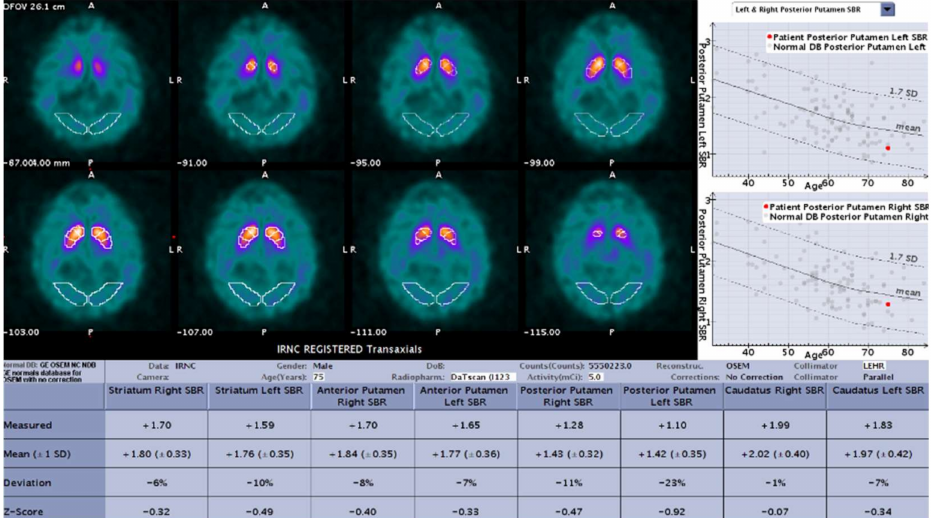
Figure 1. Sample result of the DaTQUANT software with the SBR (mean and deviation), z-scores, and percent deviation for multiple